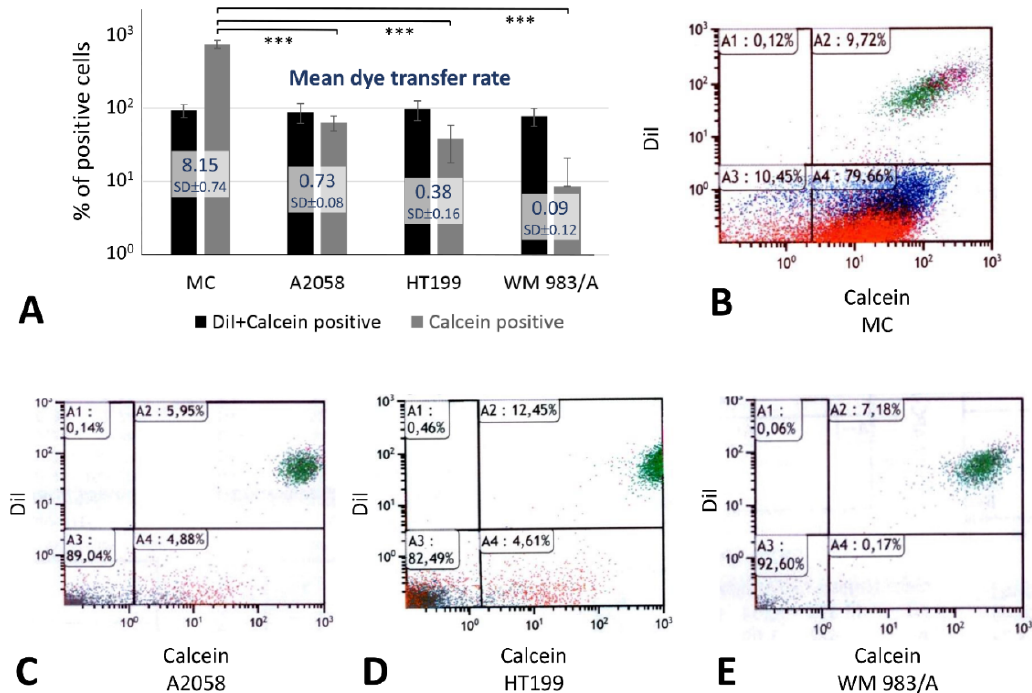
Figure 4. Functional dye-transfer tests using flow cytometry showing significantly higher rate of gap junctional direct transport of calcein from double labelled (Dil + calcein positive) cells (*** p < 0.001) into unlabeled touching cells in cultured primary melanocytes than in melanoma cell lines ( A ). Dye transfer rate ( A ) indicates the mean number of single calcein labelled cells coupled to each double labelled cell. Results show the mean ± standard deviation of three parallel experiments with each cell line. Representative examples of flow cytometry on melanocyte/MC ( B ), as well as A2058 ( C ), HT199 ( D ) and WM983/A ( E ) melanoma cultures.